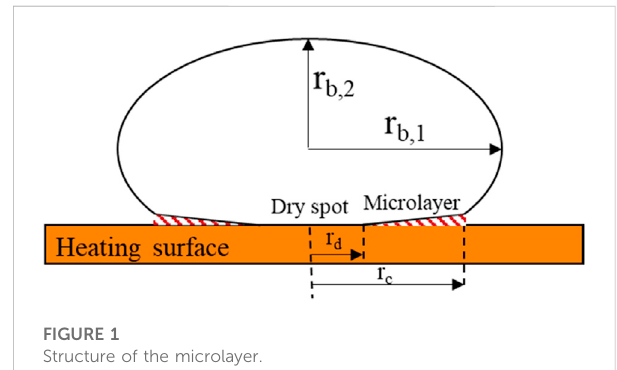
FIGURE 1 Structure of the